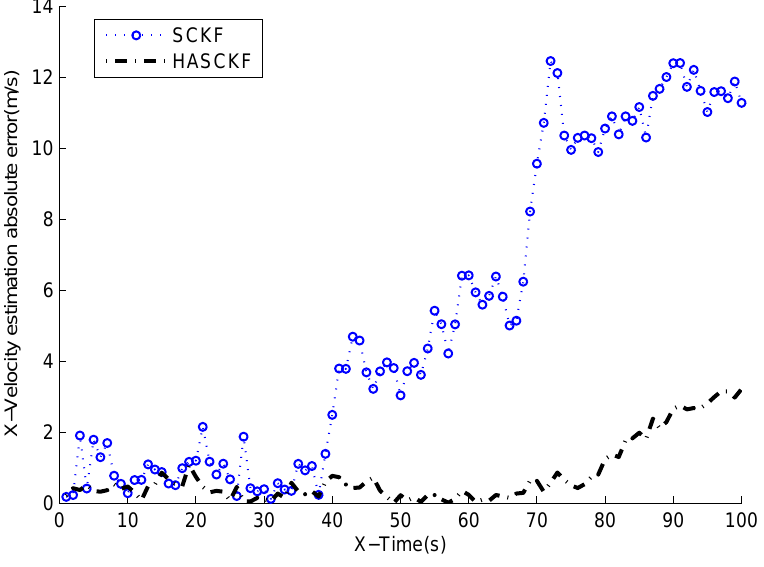
Figure 8. Absolute error curves of Y-displacement.